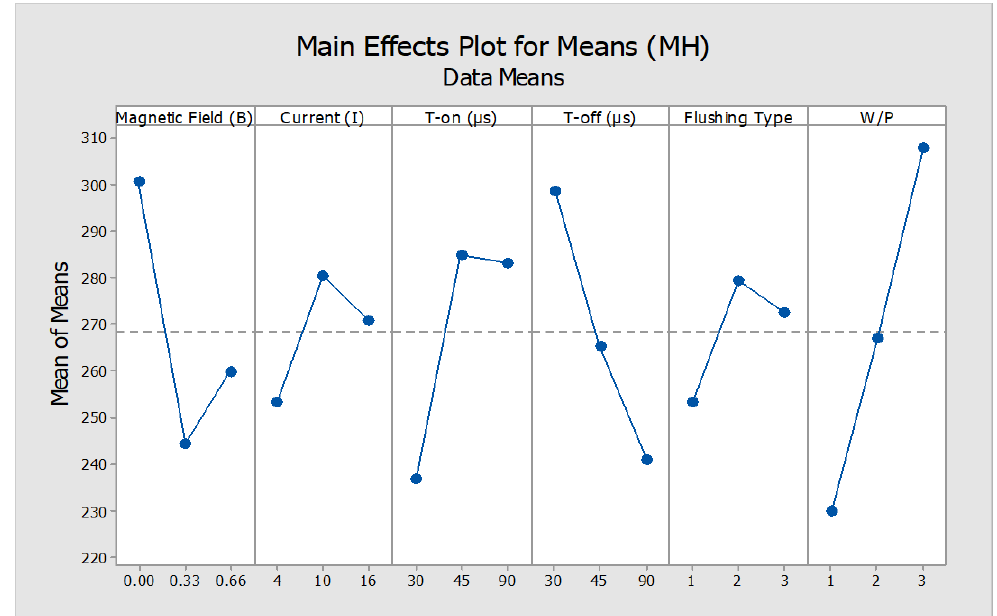
Figure 6. Main Effects plot for means for Microhardness (HV).